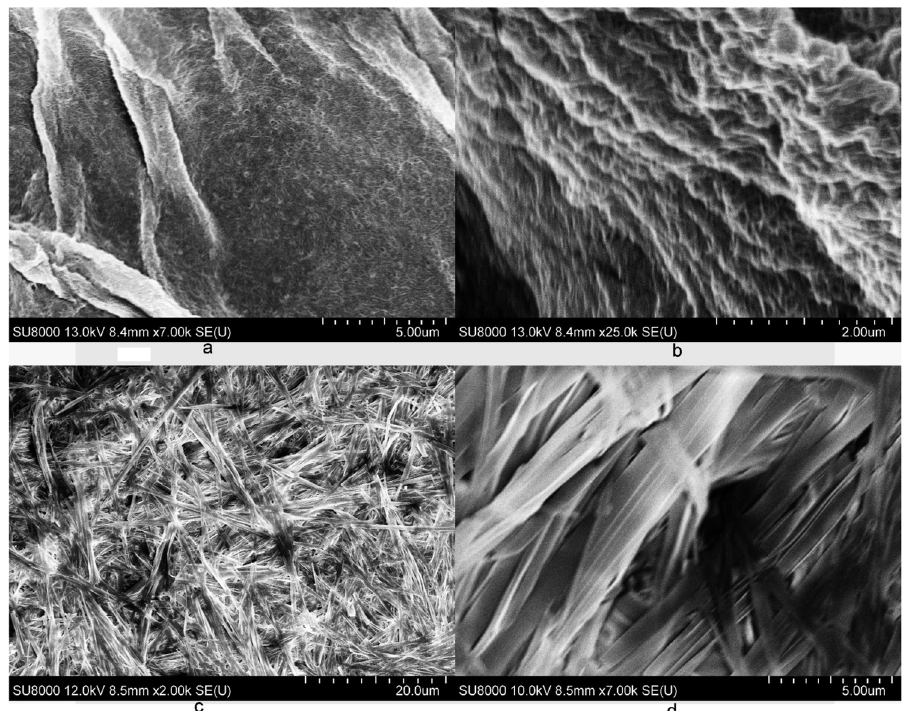
Figure 16 . Scanning electron micrographs showing the morphology of two gels: ( a and b ) compound 22i in EtOH:H 2 O ( v / v 1: 1) at 2.5 mg mL − 1 , ( c and d ) compound 22j in EtOH:H 2 O ( v / v 1: 1) at 4.0 mg mL − 1 . Reprinted with permission from [54].